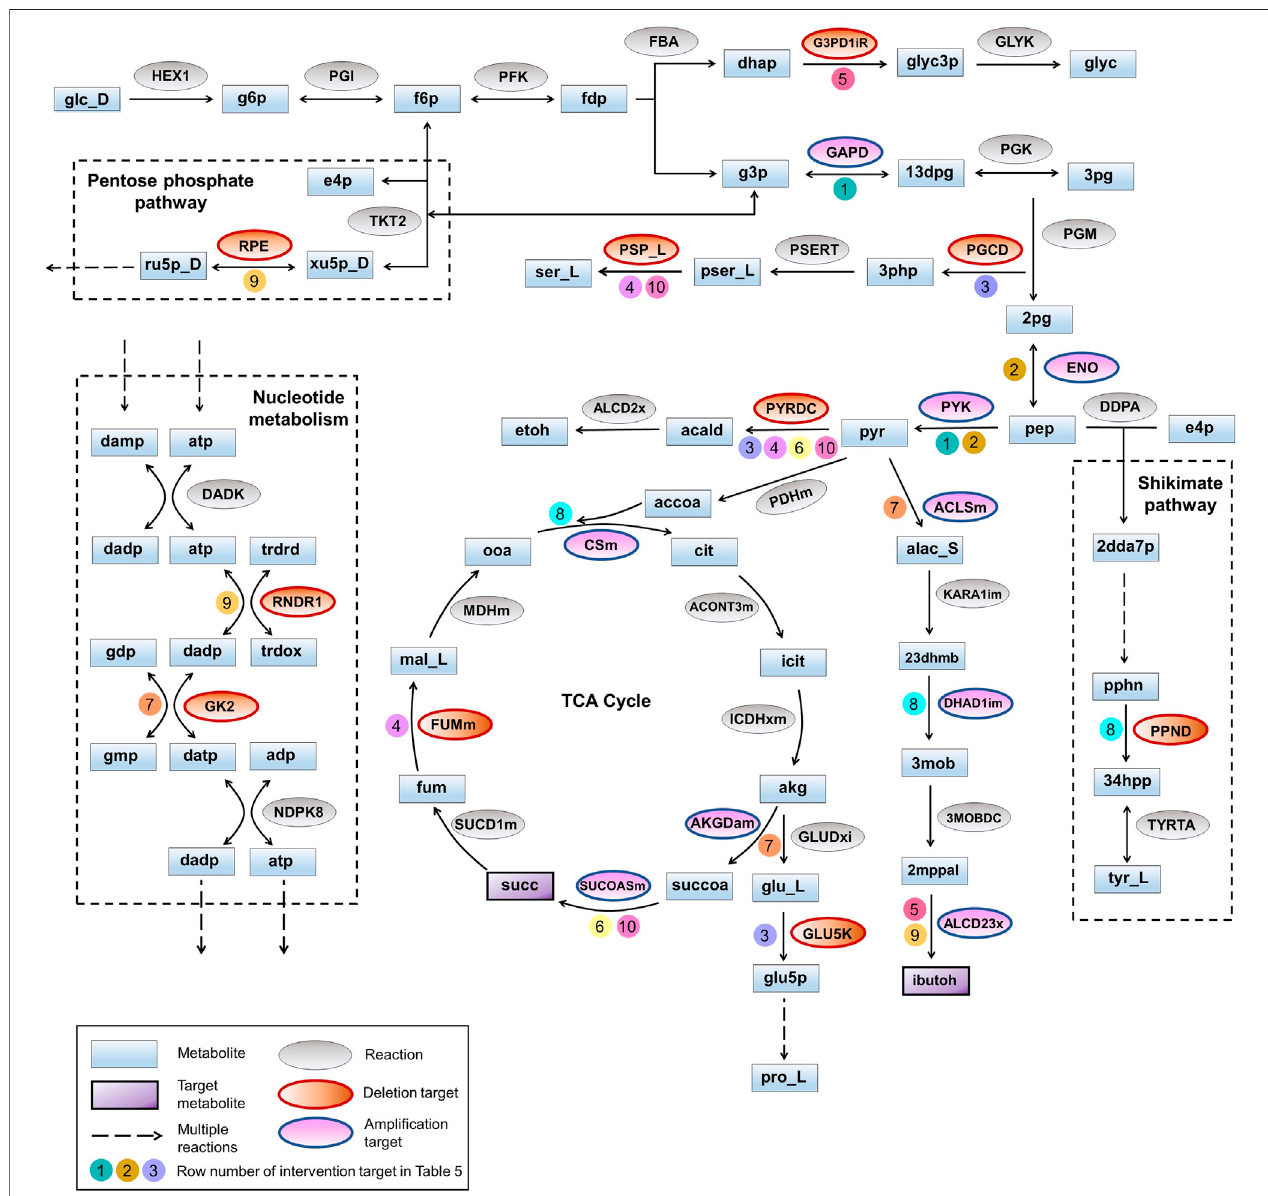
FIGURE3 | Pathway diagram for co-production ofisobutanoland succinate. The pathways for production of isobutanol and succinate are represented along with the intervention strategies listed in Table 5 . Auxiliary pathways that are not directly related to the biosynthesis of target products but contain intervention strategies are shown within dotted rectangles. Co-factors and other small molecules are not depicted for better clarity. Numbers on the arrows point to row numbers in Table 5 .